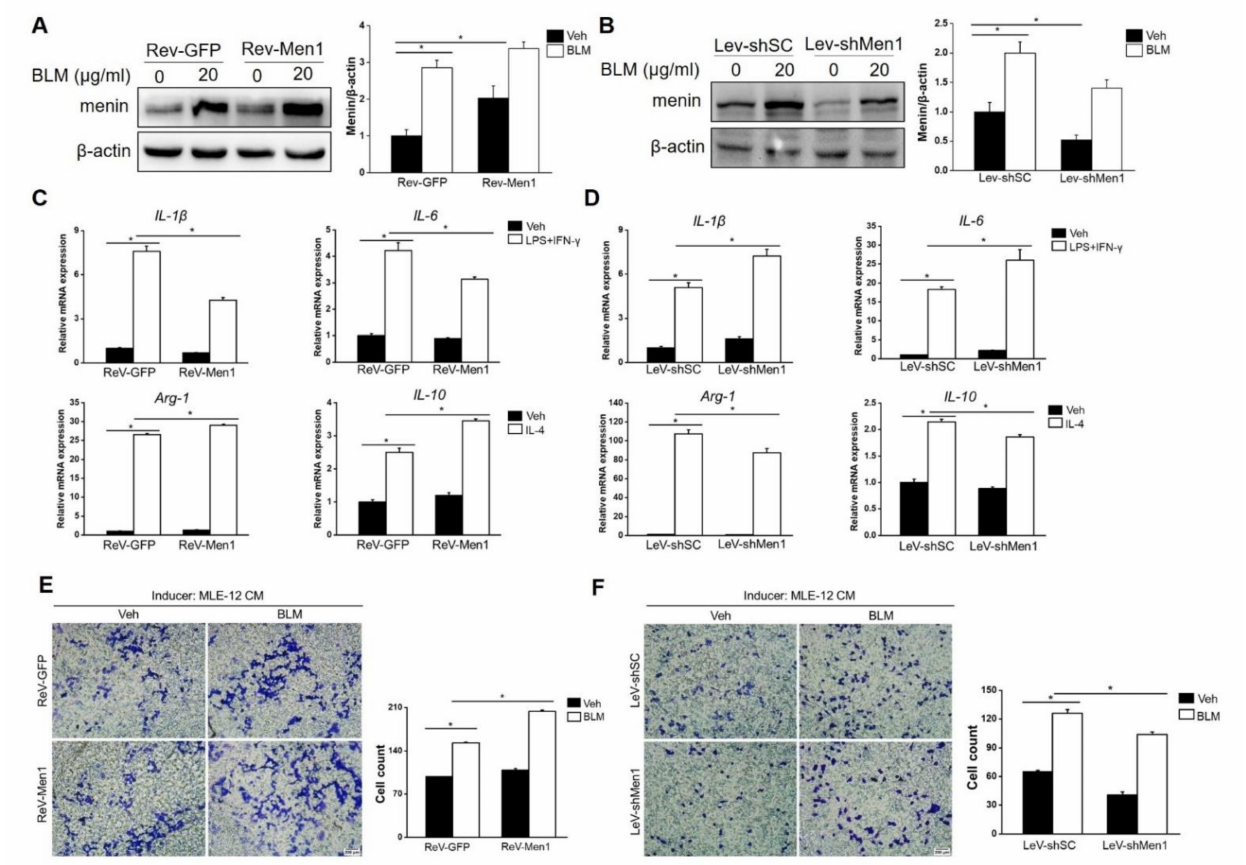
Figure 5. Men1 plays a profibrotic role in macrophages. ( A , B ) Raw264.7 cells were infected with retrovirus ( A ) or lentivirus ( B ) to overexpress or knockdown Men1 . The protein level of menin in Raw264.7 cells upon BLM treatment was determined by Western blotting, blots from three repeated experiments were quantified using Image J software ( C , D ). M1 macrophages were induced by LPS and IFN γ , and M2 macrophages were induced by mouse recombinant IL-4. The M1 (IL-1 β and IL-6) and M2 (Arg-1 and IL-10) markers were determined by qRT-PCR. Data are from three repeated experiments. ( E , F ) MLE cells were exposed to BLM for 24 h, and the culture supernatant was used as a chemokine. Transwell inserts were used to detect the migration of of Men1 overexpressing ( E ) or Knockdown ( F ) Raw264.7 cells upon the addition of supernatant from MLE cells. The statistics are from three repeated experiments. Scale bar: 200 µ m. * p <